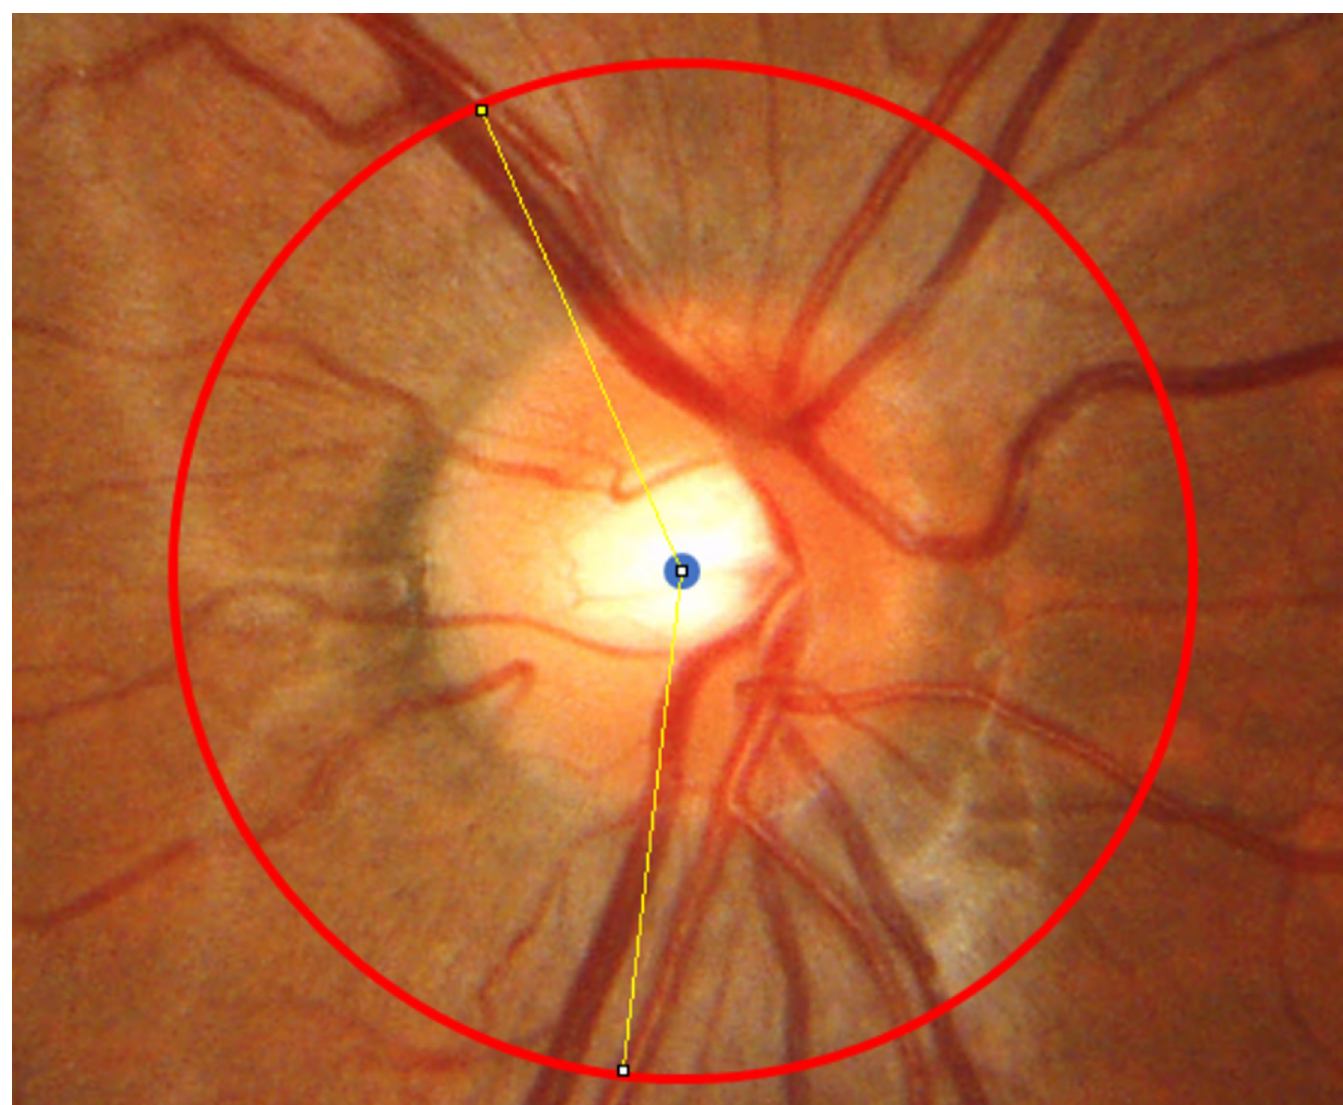
Fig 3. An example of the peripapillary retinal arteries angle measurement (right eye). The peripapillary retinal arteries angle (PRAA) was calculated by identifying the angle between the intersecting positions (white dots) of a 3.4-mm-diameter peripapillary scan circle (yellow) and the supratemporal/infratemporal major retinal